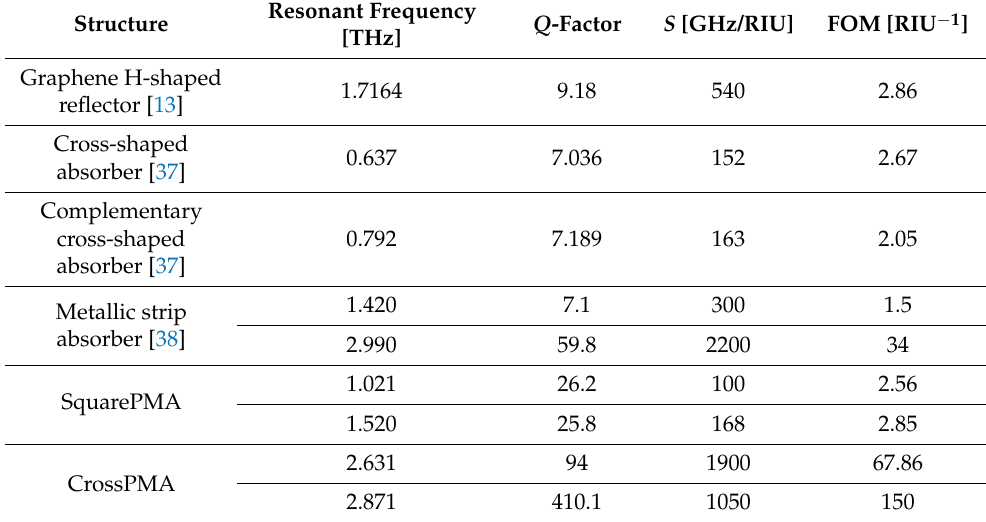
Table 8. Comparison of sensor properties among designs in previous